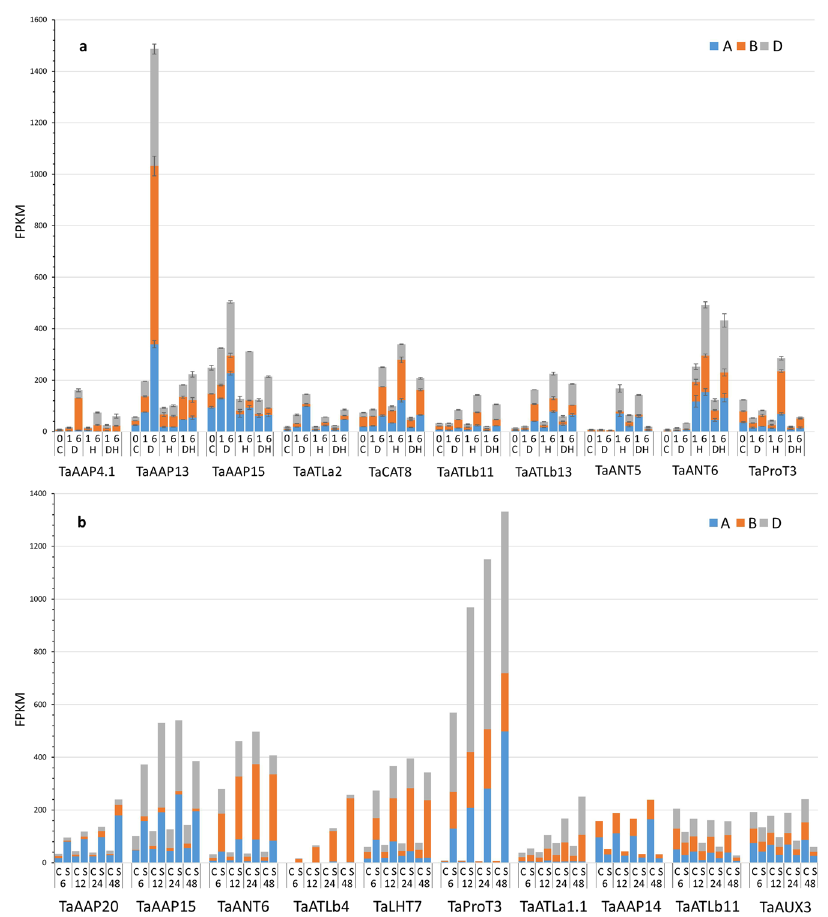
Figure 5. FPKM values of AATs and their homeologs highly induced by heat (H), drought (D), and combined heat + drought (DH) stress in 7-day-old leaf at 0 (control), 1, and 6 hours (5a), salt stress in 10-day-old root at 6, 12, 24, and 48 hours (5b). A, B, and D represent A, B, and D homeologs expression